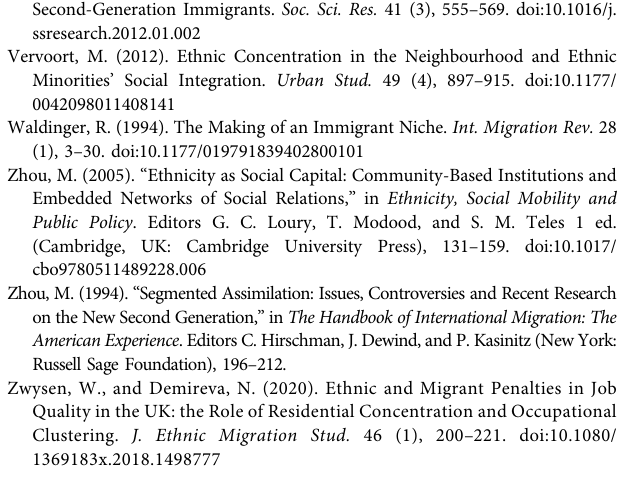
Tabellini, M. (2020). Gifts of the Immigrants, Woes of the Natives: Lessons from the Age of Mass Migration. Rev. Econ. Stud. 87 (1), 454 – 486. doi:10.1093/ restud/rdz027 Vervoort, M., Dagevos, J., and Flap, H. (2012). Ethnic Concentration in the Neighbourhood and Majority and Minority Language: A Study of First